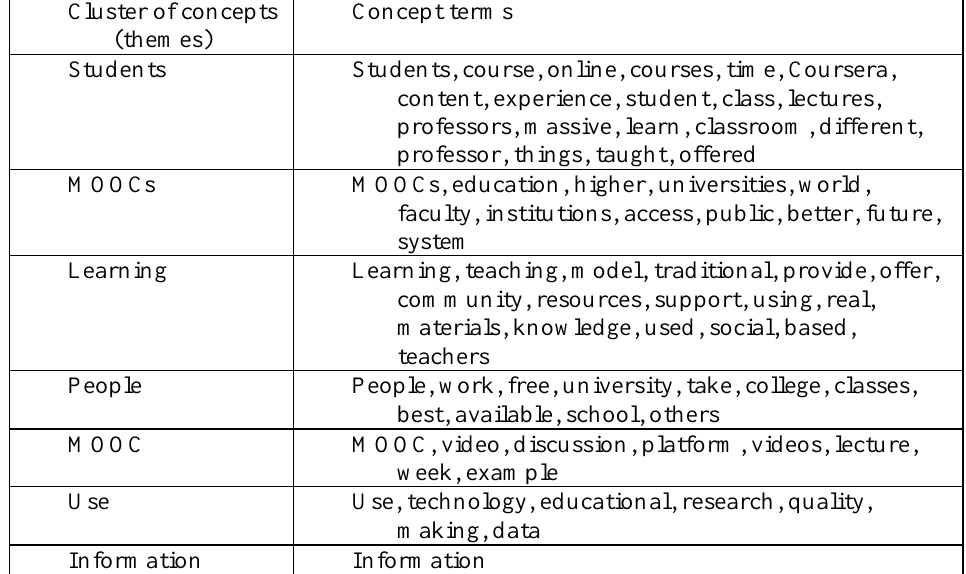
Table 2 Cluster of Concepts Associated with MOOCs in Blog Posts Cluster of